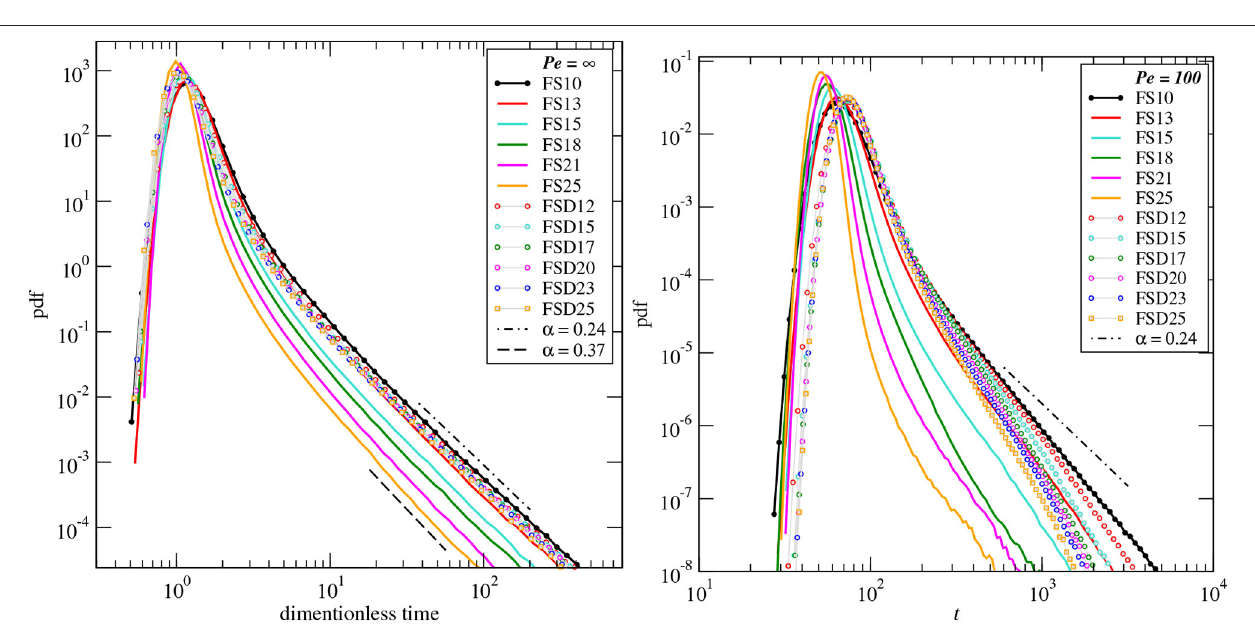
FIGURE 7 | Flux weighted Langrangian speed auto-correlation function ϒ v the decorrelation length ℓ c and the right panel displays the ratio η = ℓ c /λ vs. porosity.